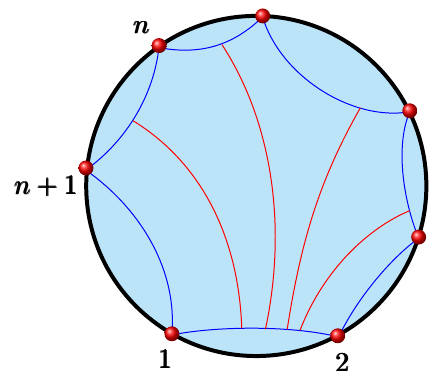
Figure 7 . A canonical choice of diagonals: they all start from the edge (12) and touch the non adjacent